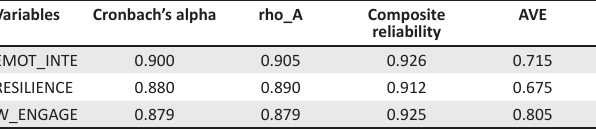
TABLE 3 : Quality criteria of the measurement or outer